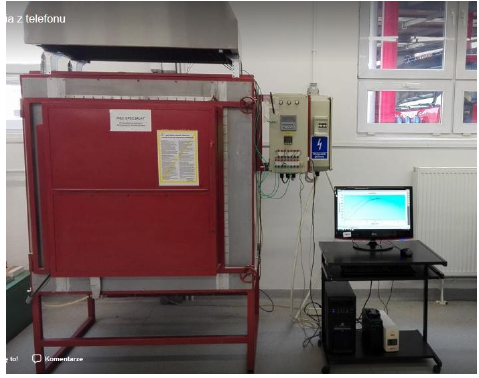
Figure 1. View of the PK 1100/5 chamber furnace with instrumentation.